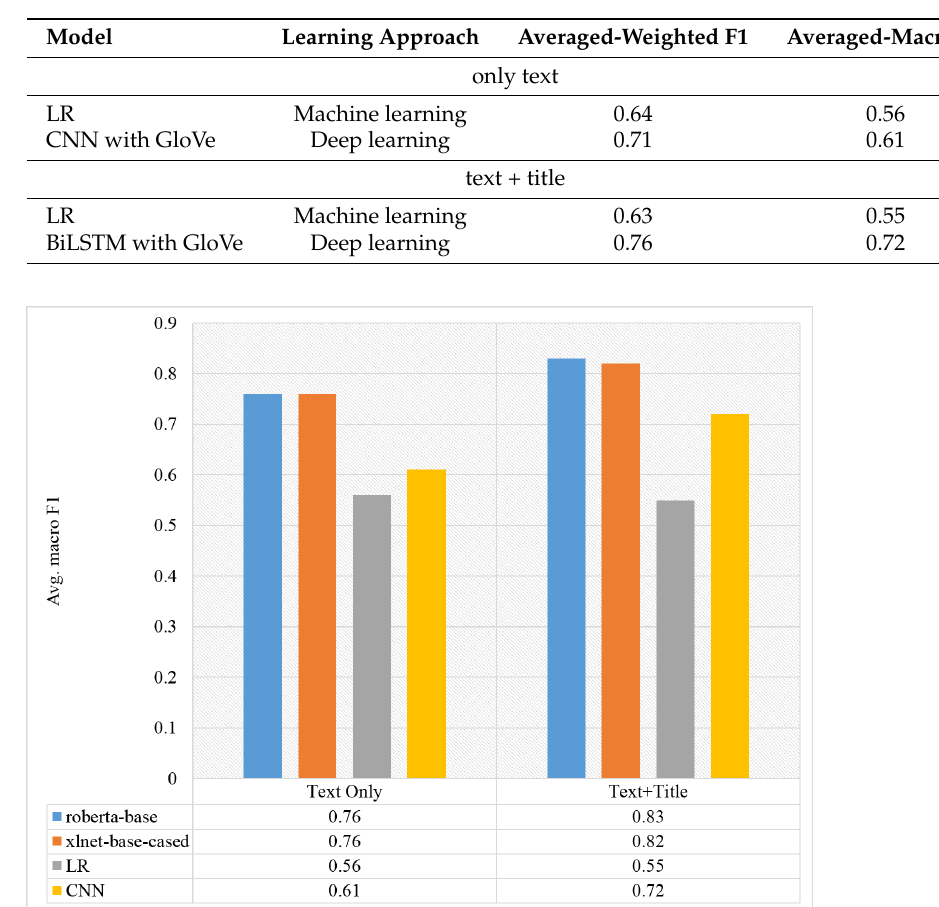
Figure 2. Comparison of best performing models for regret